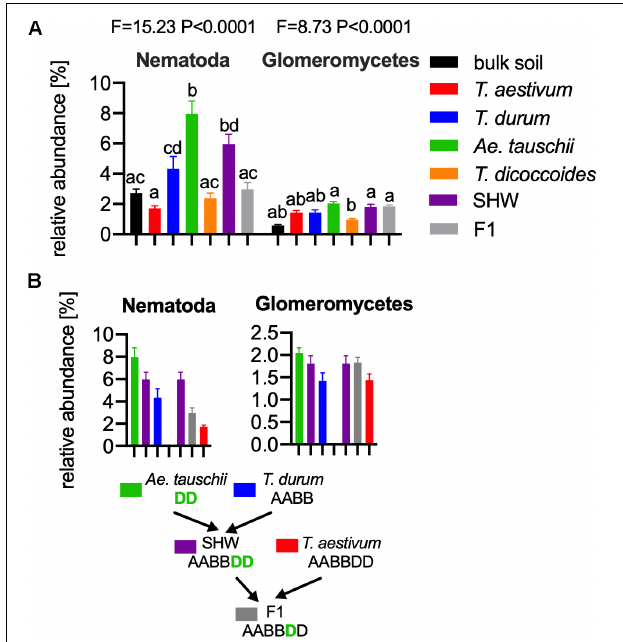
FIGURE 6 | (A) The relative abundance of Nematoda (left) and Glomeromycetes (right) in the microbial eukaryotic community. ANOVA F and P values are provided, and the letters present the result of pair-wise t -test with Bonferroni correction. (B) A. tauschii derived D genome increases the influence of these taxa, while the artificially selected D does not have such an effect, for panels (A,B) error bars represent standard error. Arrows indicate the hybridization and crosses conducted in this study. Different letters reflect significant difference between datasets in pair-wise t